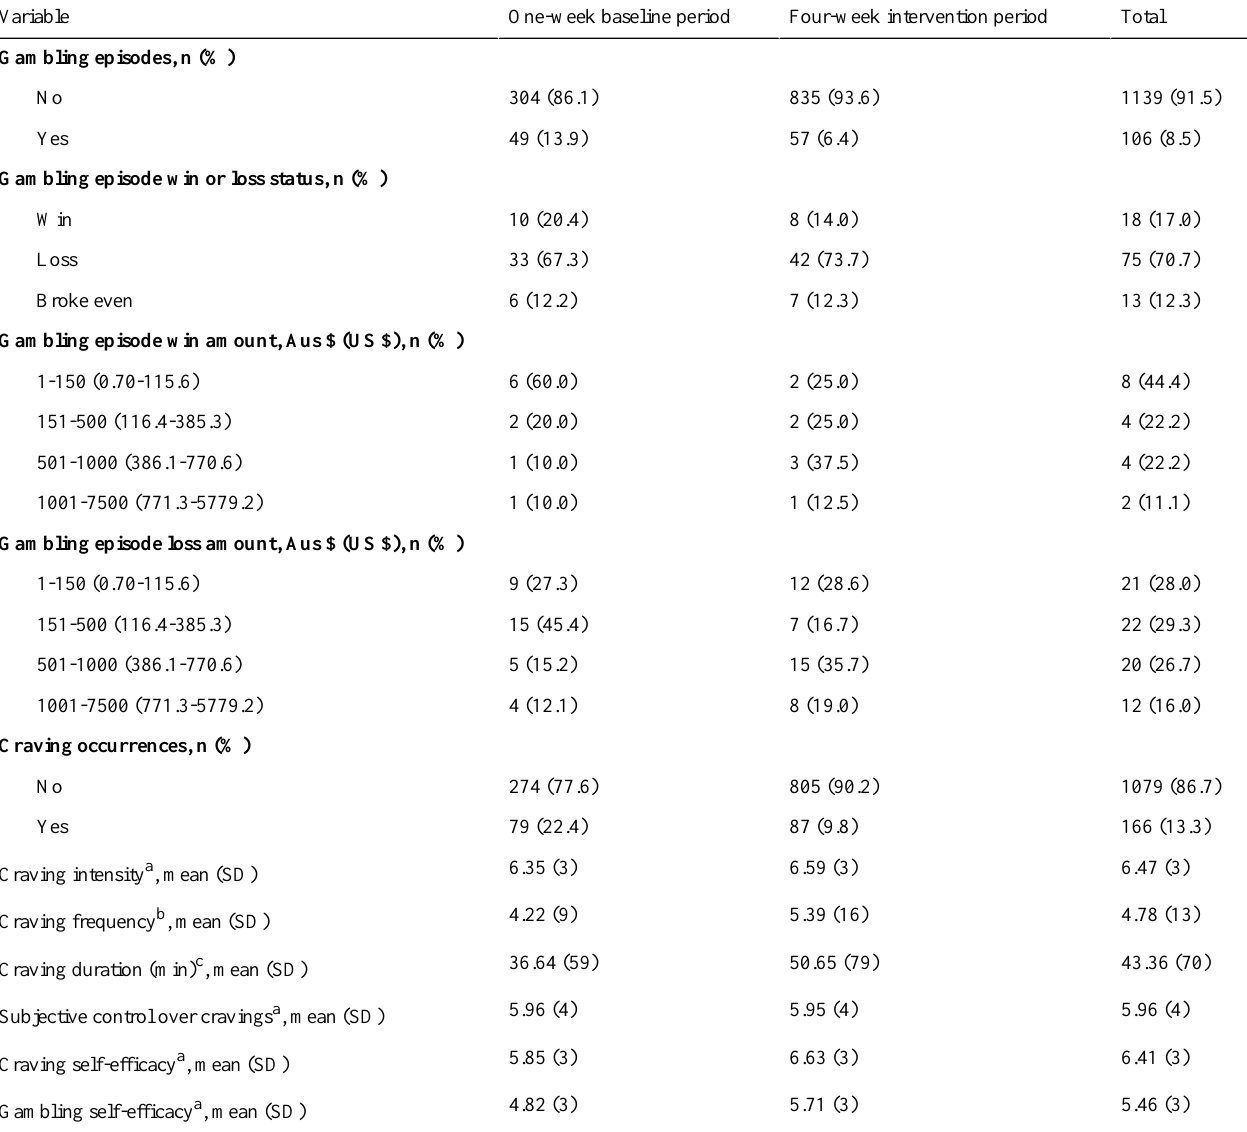
Table 4. Descriptive statistics of ecological momentary assessment outcome variables